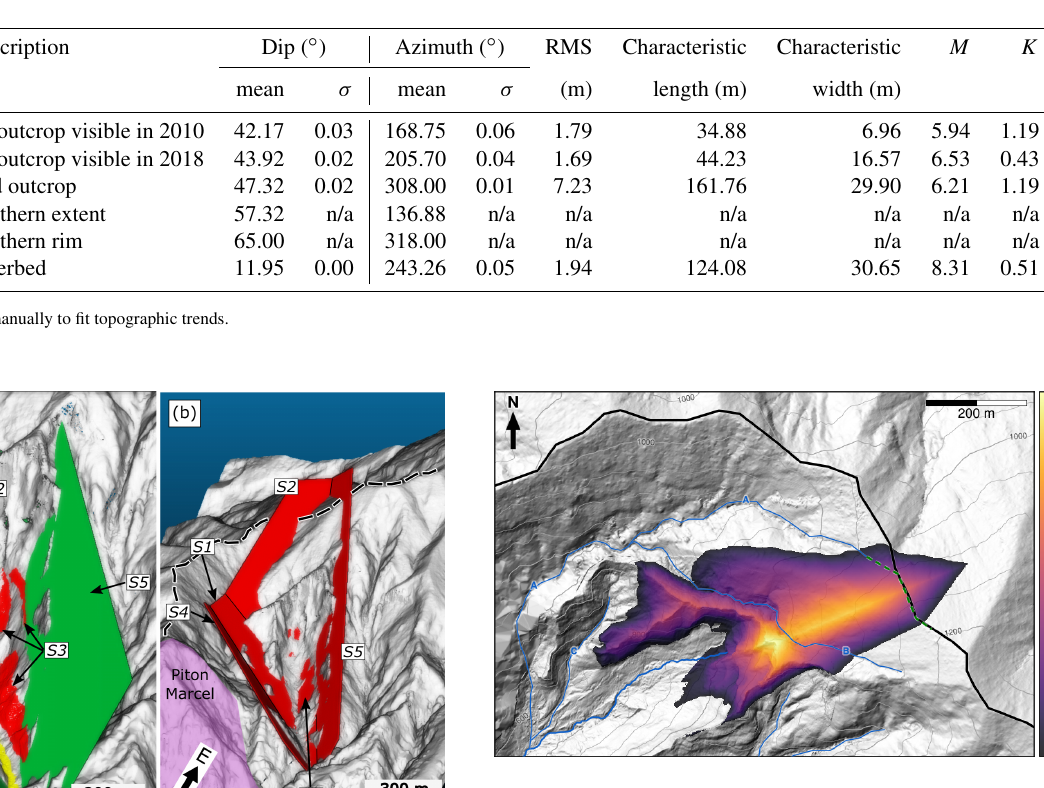
Figure 8. Potentially unstable volume. The height between the re- constructed basal surface (see Fig. 7b) and the combined July 2010– August 2018 DEM (displayed here) is given by the color scale. We only display heights above the contact between D and UPd units, as well as LPd and Upd units, and disregard heights below 1m. The Samperre river (thick blue line), ravines (thin blue lines) and the Prêcheur destabilization structure (black line) are displayed as in Fig. 1. The unstable volume is computed either directly or by limiting the extent of the collapse (i) to ravine A continued along a topographic edge (dashed green line) or (ii) to ravine B (see Ta- ble